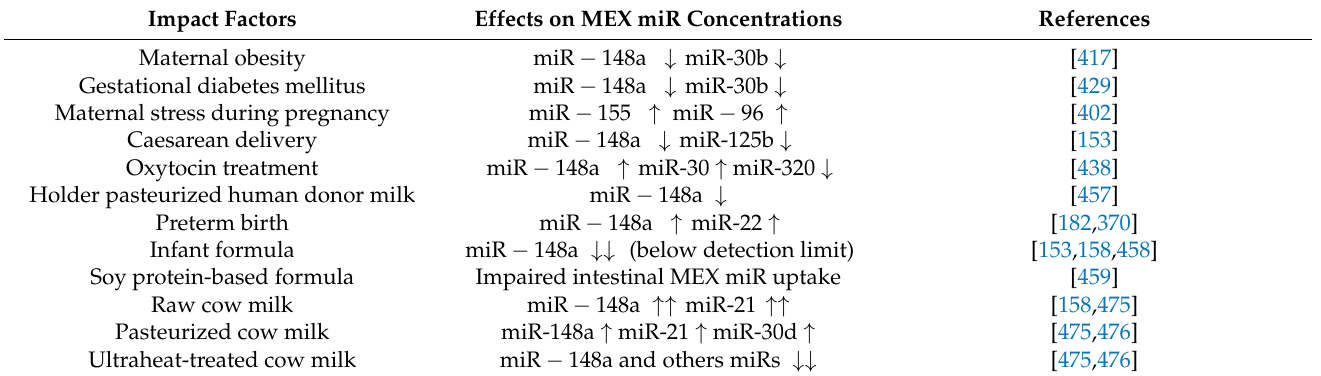
Table 2. Perinatal factors modifying MEX miR